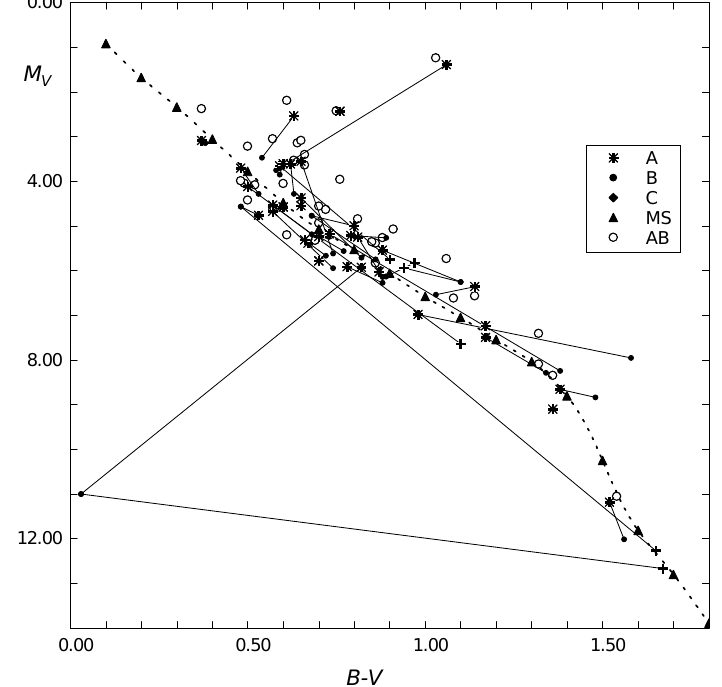
Fig. 1. Color-magnitude diagram for Population II binaries. A,B,C are the resolved components; AB – combined light of both components; MS – the main-sequence